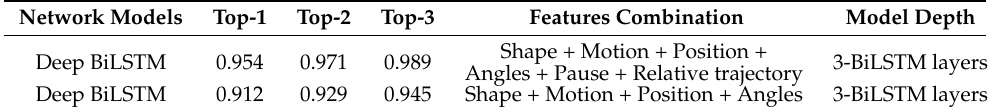
Table 9. Performance accuracy of the developed models.